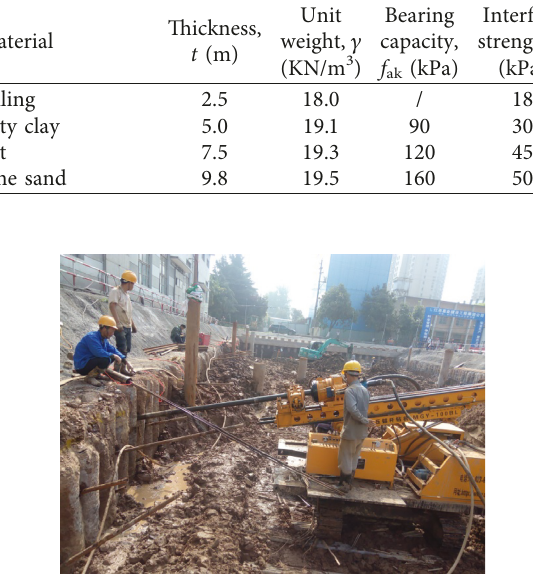
Figure 10: Preholed inflatable retrievable anchor.